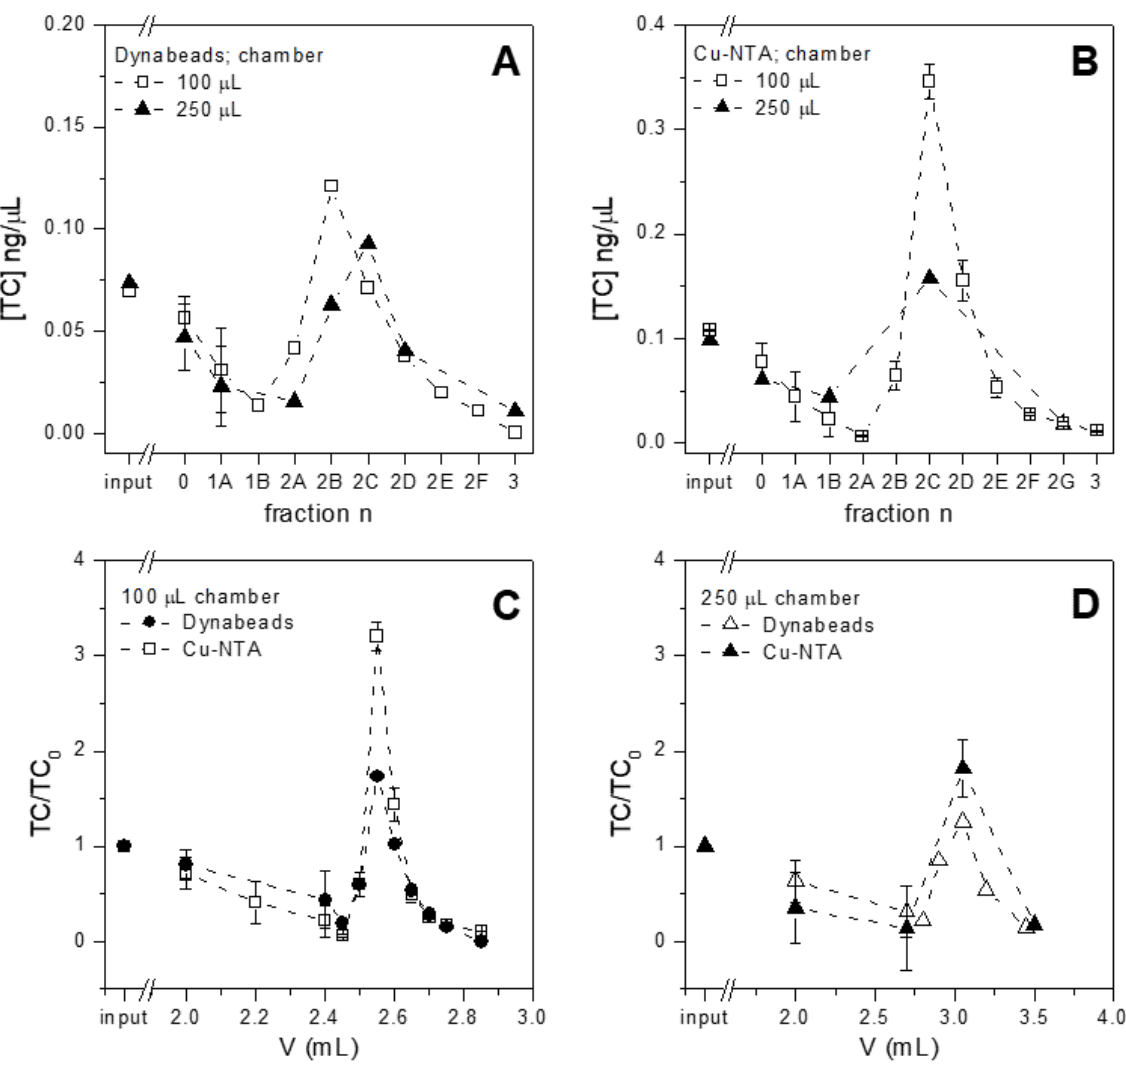
Figure 5. Purification of tetracycline spiked in buffer with microfluidic chips carrying chambers of different volumes and loaded with the two types of beads. Panel ( A ): Dynabeads tested in different chambers; panel ( B ): Cu-NTA beads in different chambers. The x axis shows the fractions collected at the outlet of the system, and in particular, fraction 0 represents the tetracycline collected during injection (unbound), fractions 1A–1B represent the volume collected during washes, while fractions 2A–2G represent the volume collected during the elution step and finally, fraction 3 represents a final wash; Panels ( C , D ): the tetracycline concentration found in different fractions was normalized to the concentration of injected tetracycline (TC/TC 0 ) in same volume chambers (100 µL in panel ( C ) and 250 µL in panel ( D )) loaded with the two types of beads. The x axis shows the volume fluxed in the microfluidic